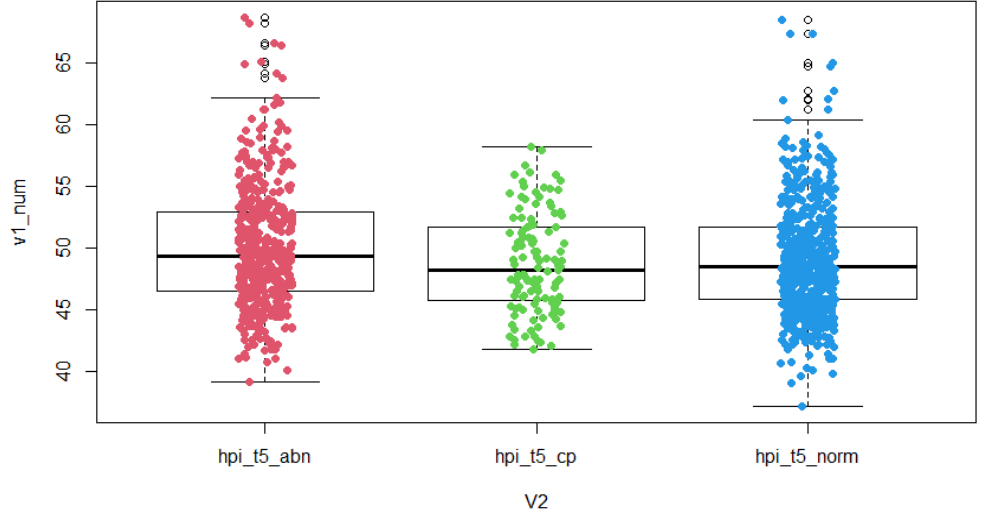
Figure 2. Time-lapse distribution—t5 in groups of PGT-A abnormal embryos, normal embryos with proven clinical pregnancy and normal embryos. Boxplot is categorized by groups: abn—PGT-A abnormal embryos, cp—PGT-A normal embryos with clinical pregnancy, norm—PGT-A normal embryos, hpi = hours post insemination, v1_num = numerically expressed time, v2 = identification of grouped variables containing the type of embryo.